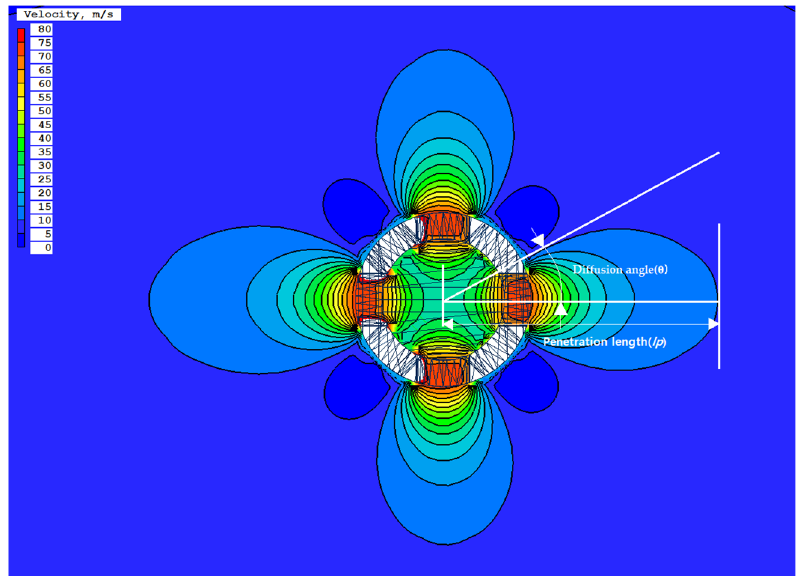
Figure 7. Two-dimensional view of mixed gas formation around the injection port at the 5th row; (diffusion angle ( θ ), penetration length ( 𝑙 (cid:3043) )).